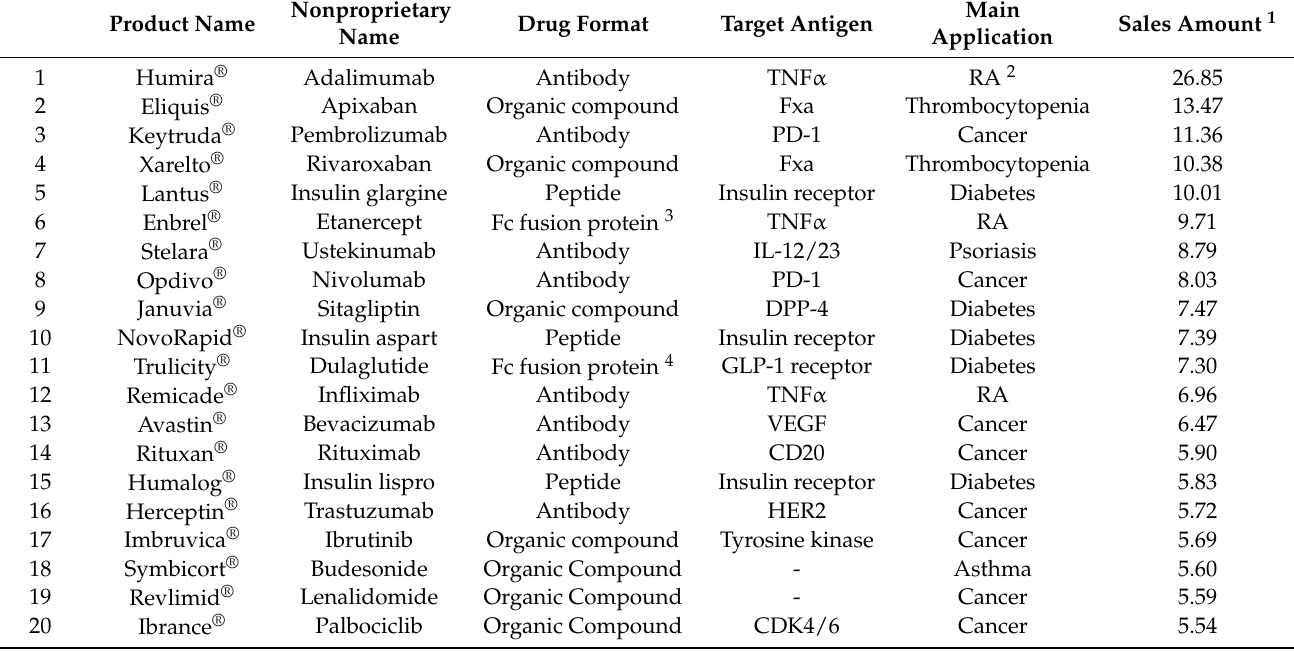
Table 3. The top 20 pharmaceutical products worldwide by sales in